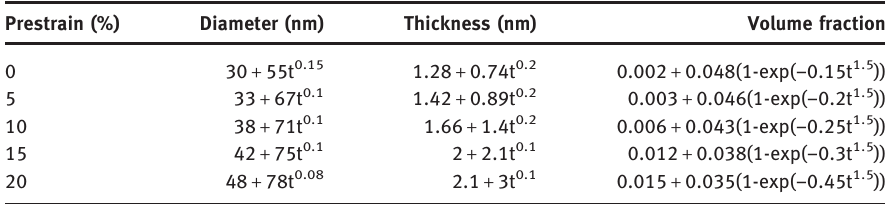
Table 1: Fitting equations for the experimental values. Prestrain (%) Diameter (nm) Volume fraction